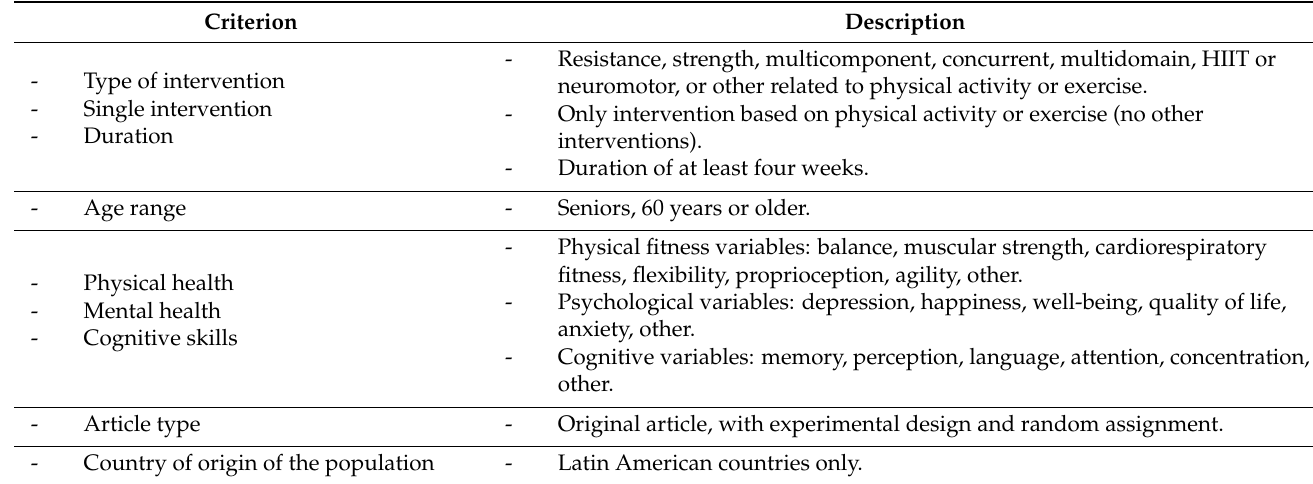
Table 1. Inclusion criteria of the